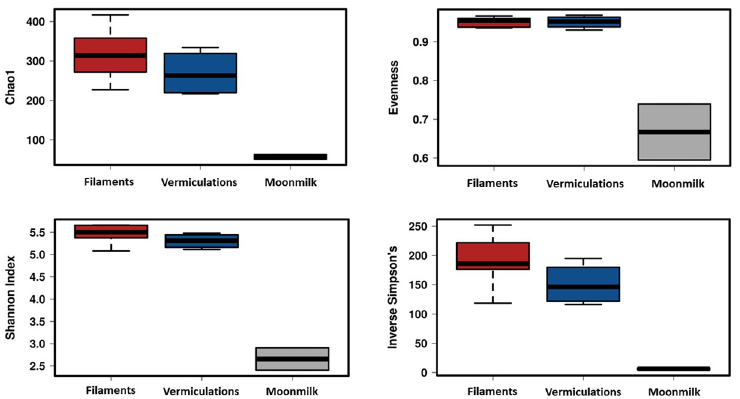
Fig 4. Diversity indices of the different biofilms from Fetida Cave. The three different box plots include the data corresponding to all the samples representing each biofilm/deposit. Water filament samples are reported in red, vermiculation samples are shown in blue, moonmilk deposit samples are grey.